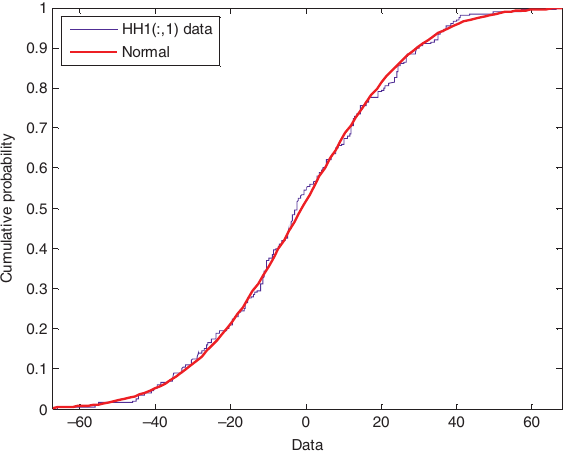
Figure 5: Cumulative Distribution Plot for HH